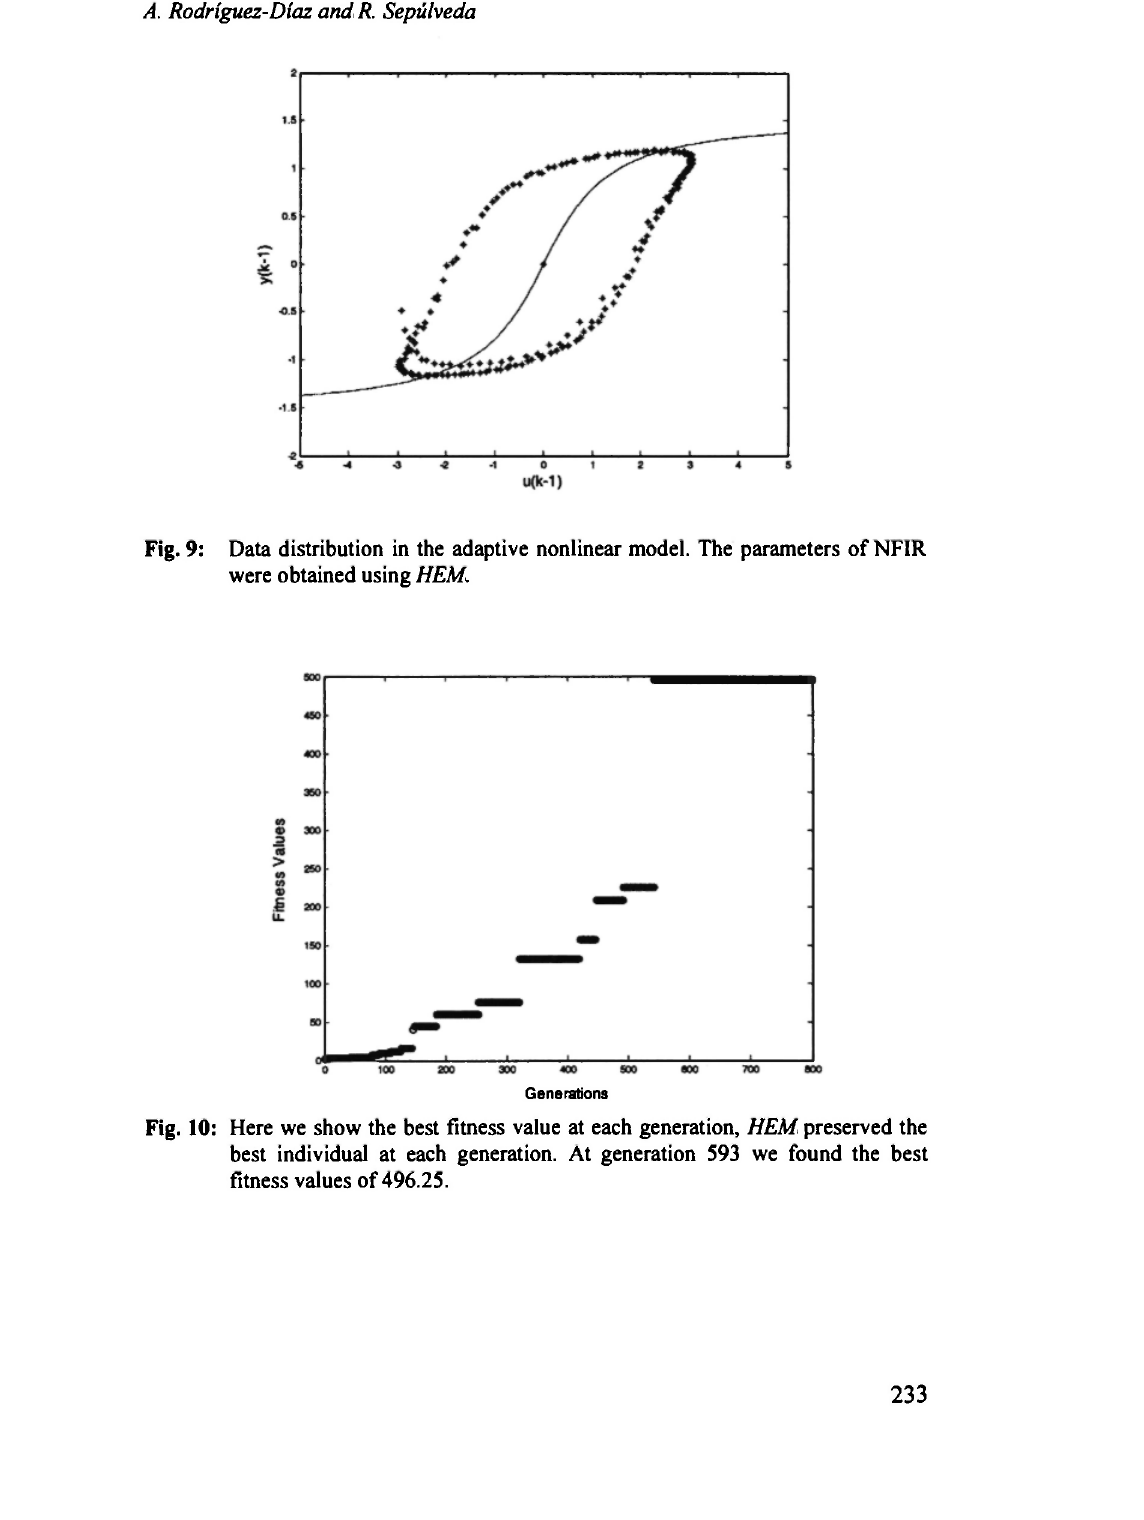
Fig. 9: Data distribution in the adaptive nonlinear model. The parameters of NF1R were obtained using HEM.